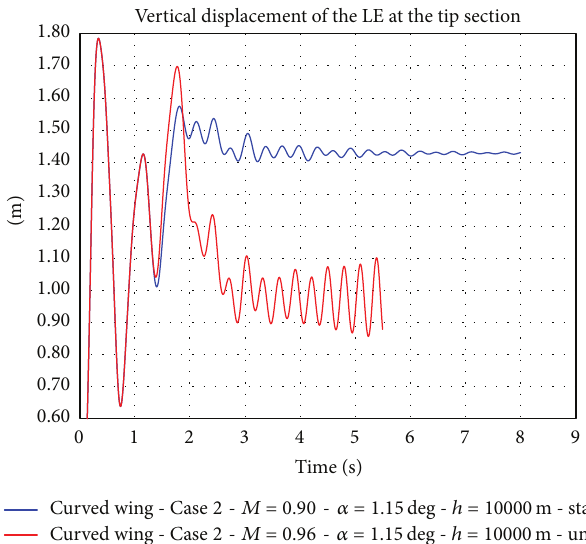
Figure 14: Results of the FSI analyses of the curved wing model (Case 2 , cruise